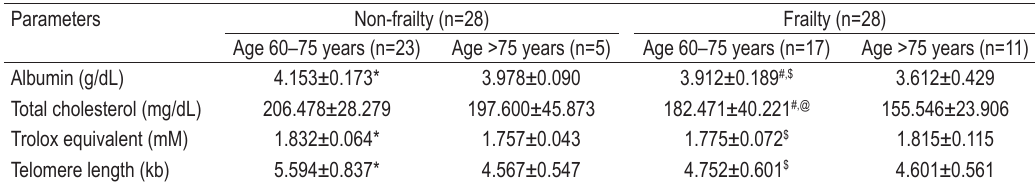
The values show mean±standard deviation. * , #, and @ indicate the significant at p<0.05 when compared with non-frailty ages >75 years, frailty ages >75 years, and subjects ages 60–75 years in frailty group, respectively. $ indicates the significant at p<0.01 when compared with and subjects ages 60–75 years in frailty